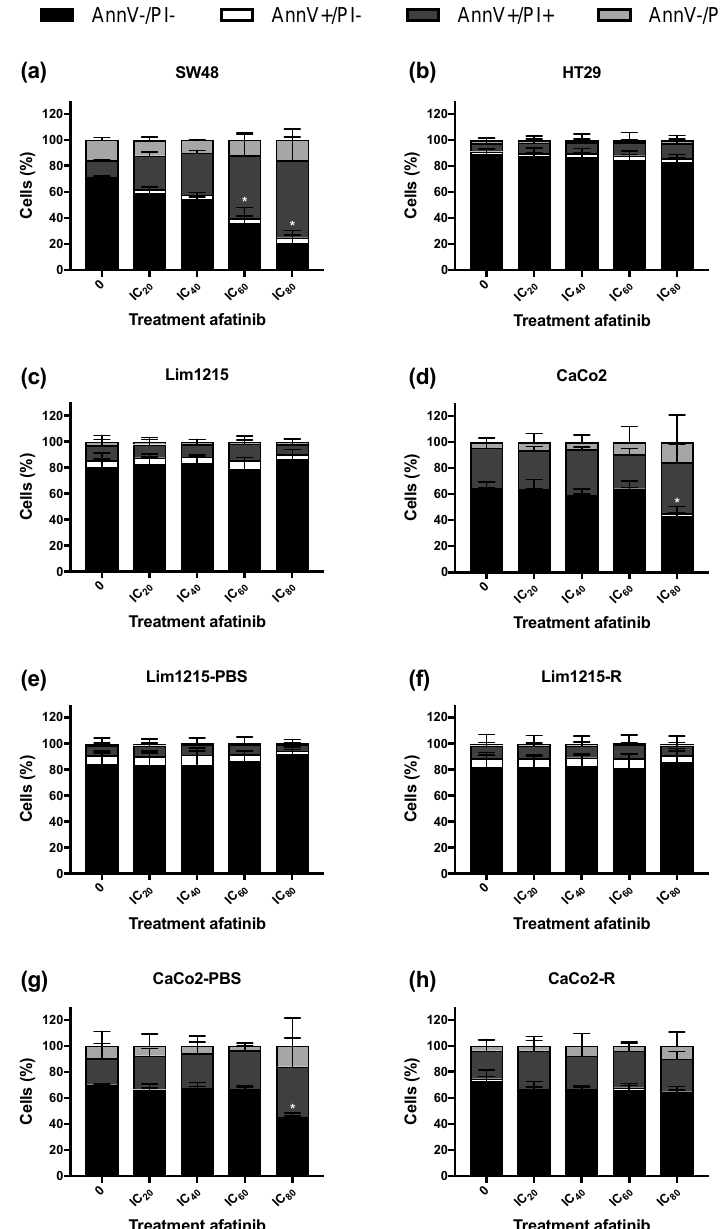
Figure 6. Induction of apoptotic cell death in CRC cell lines after afatinib treatment (72 h, 0–IC 80 ). Cells were stained with Annexin V-fluorescein isothiocyanate (AnnV-FITC) and PI and measured using flow cytometry. The effect of afatinib treatment on the induction of apoptotic cell death of intrinsically cetuximab-resistant ( a , b ) cetuximab-sensitive ( c , d ), acquired cetuximab-resistant, and corresponding isogenic cetuximab-sensitive ( e – h ) CRC cell lines. * p -value treatment effect on the percentage of cells 0.050. ≤